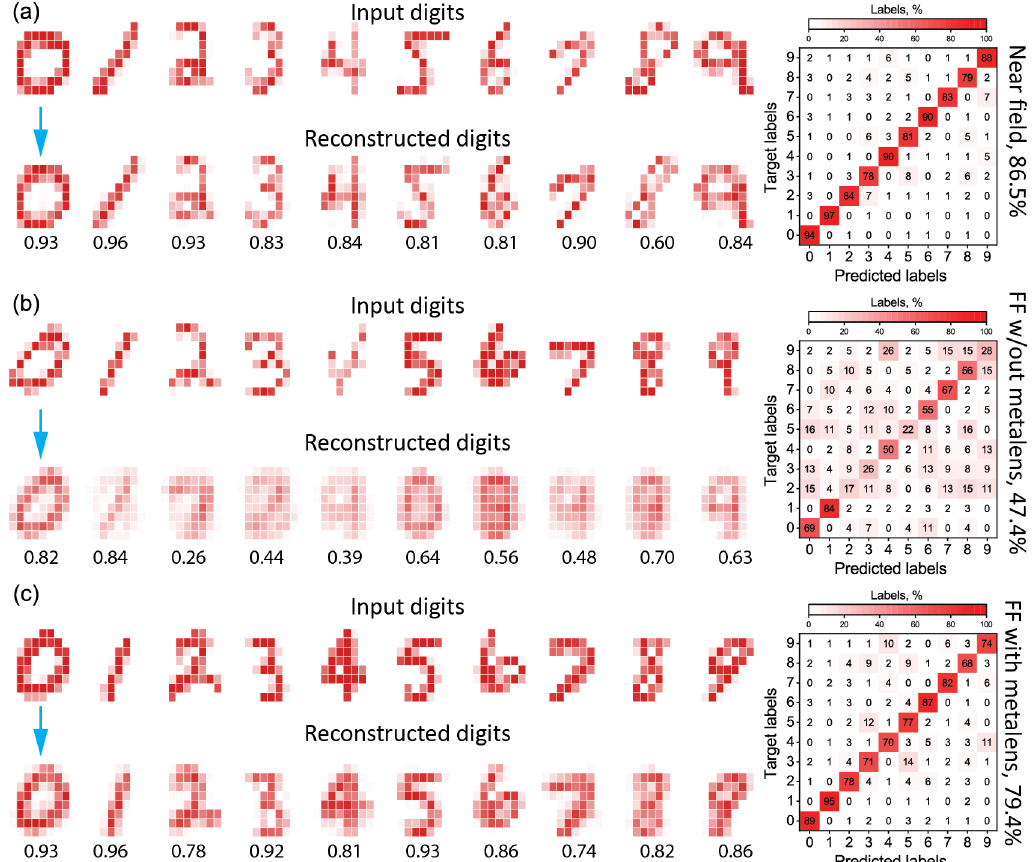
FIG. 4. Experimentally reconstructed acoustic images and their classification. Performance of the DNNs for the experimental reconstruction and classification of the handwritten input digits. (a) The reconstructed (left inset) images from the measured amplitude- phase arrays of pressure and corresponding confusion matrices for the classification problem (right inset) in the (a) near field, (b) far field without any metalens, and (c) far field with the metalens placed close to the source. The correlation coefficient between each reconstructed image and its corresponding target image is shown at the bottom of the image.